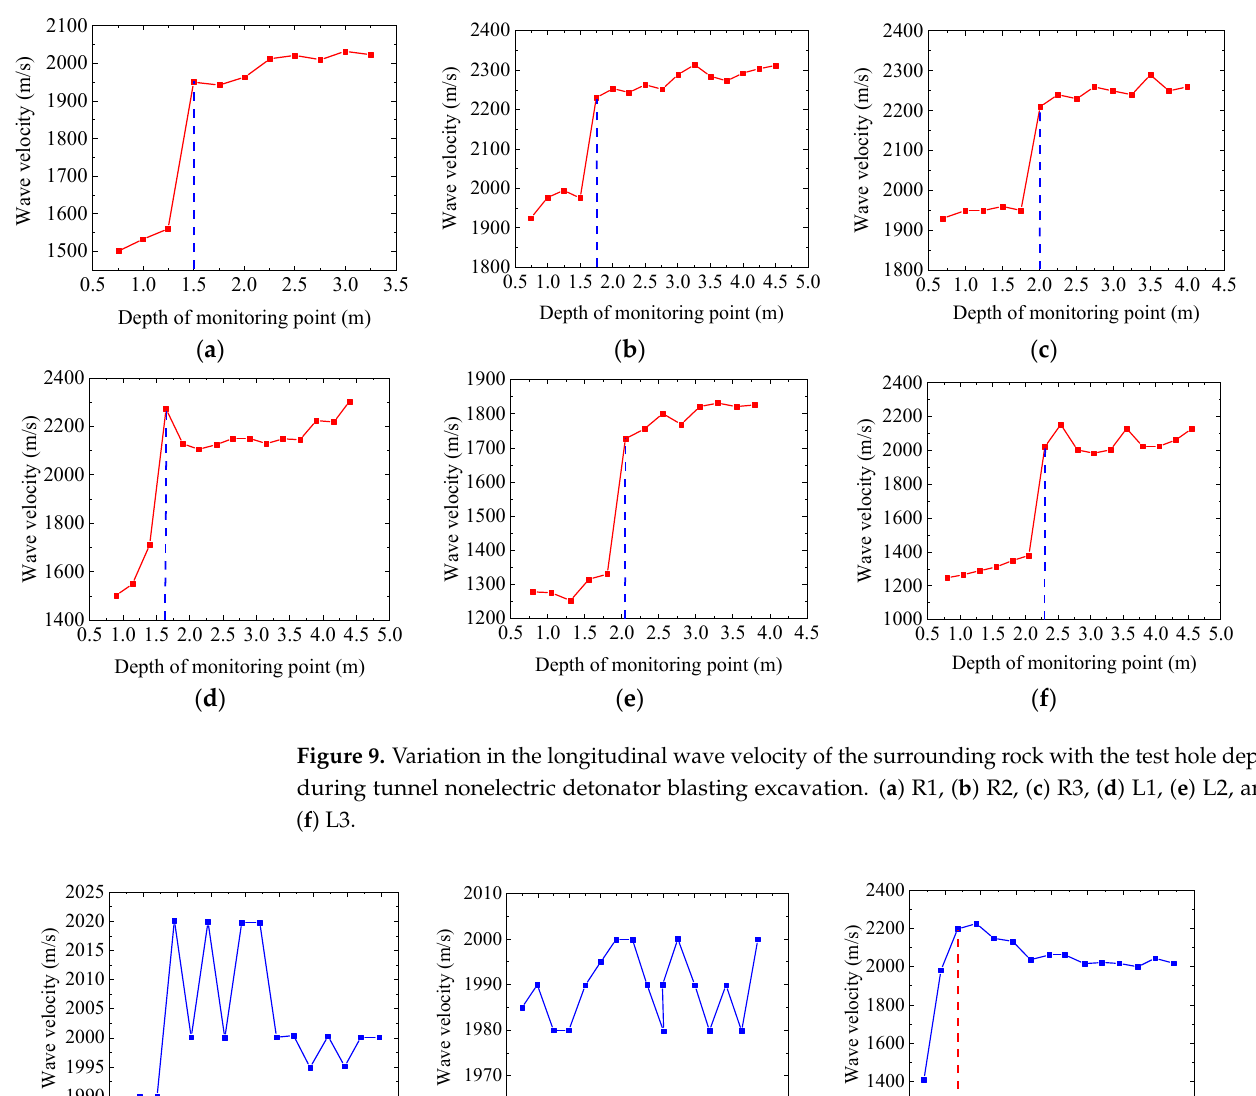
( c ) Figure 8. Field test of the loose circle. ( a ) Use support trolley to assist drilling; ( b ) install monitoring sensors; ( c ) observe the monitoring results. At present, there is no unified and clear definition of a loose tunnel circle. The tech- nical code for the construction of rock foundation excavation engineering of hydraulic structures [29] notes that the change rate of wave velocity greater than 10% after blasting is the criterion of rock mass failure. Firstly, two footage sections with similar surrounding rock properties were first selected. In order to ensure the accuracy of the monitoring re- sults, priority will be given to test work after blasting. Each monitoring test lasted nearly 12 h. The test analysis of the tunnel loose circle range excavated by nonelectric and elec-